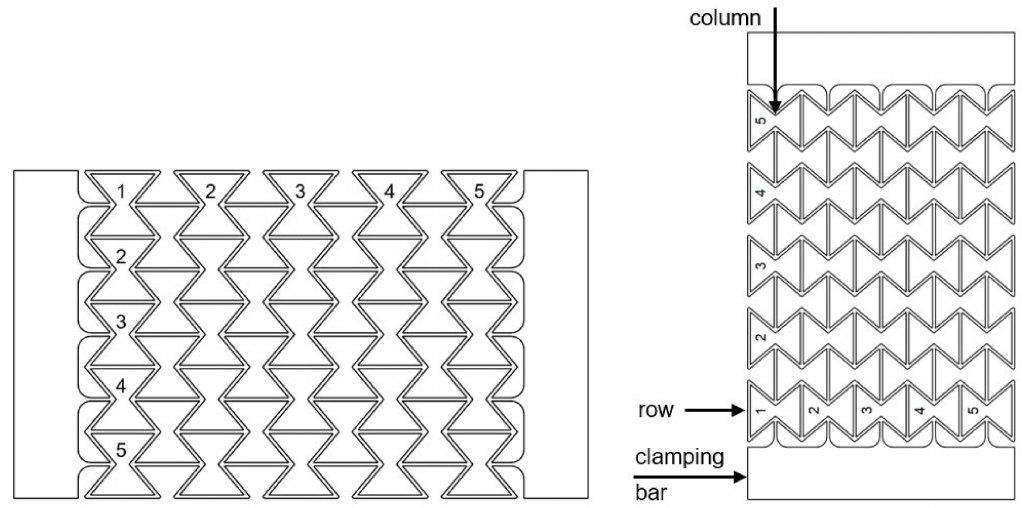
Figure 8. Schematic representation of the honeycomb structure used with the clamping